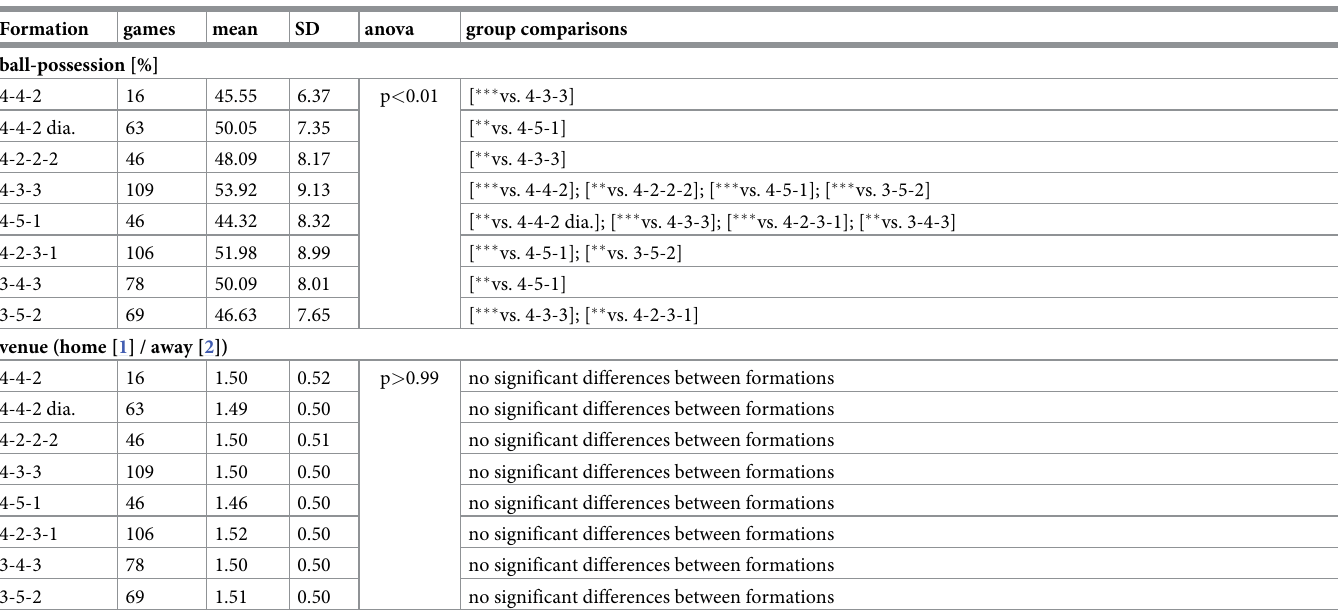
S1 Table. Descriptive values (mean ± SD) per position (center back, full back, central mid- fielder, wide midfielder, forward) depending on the tactical